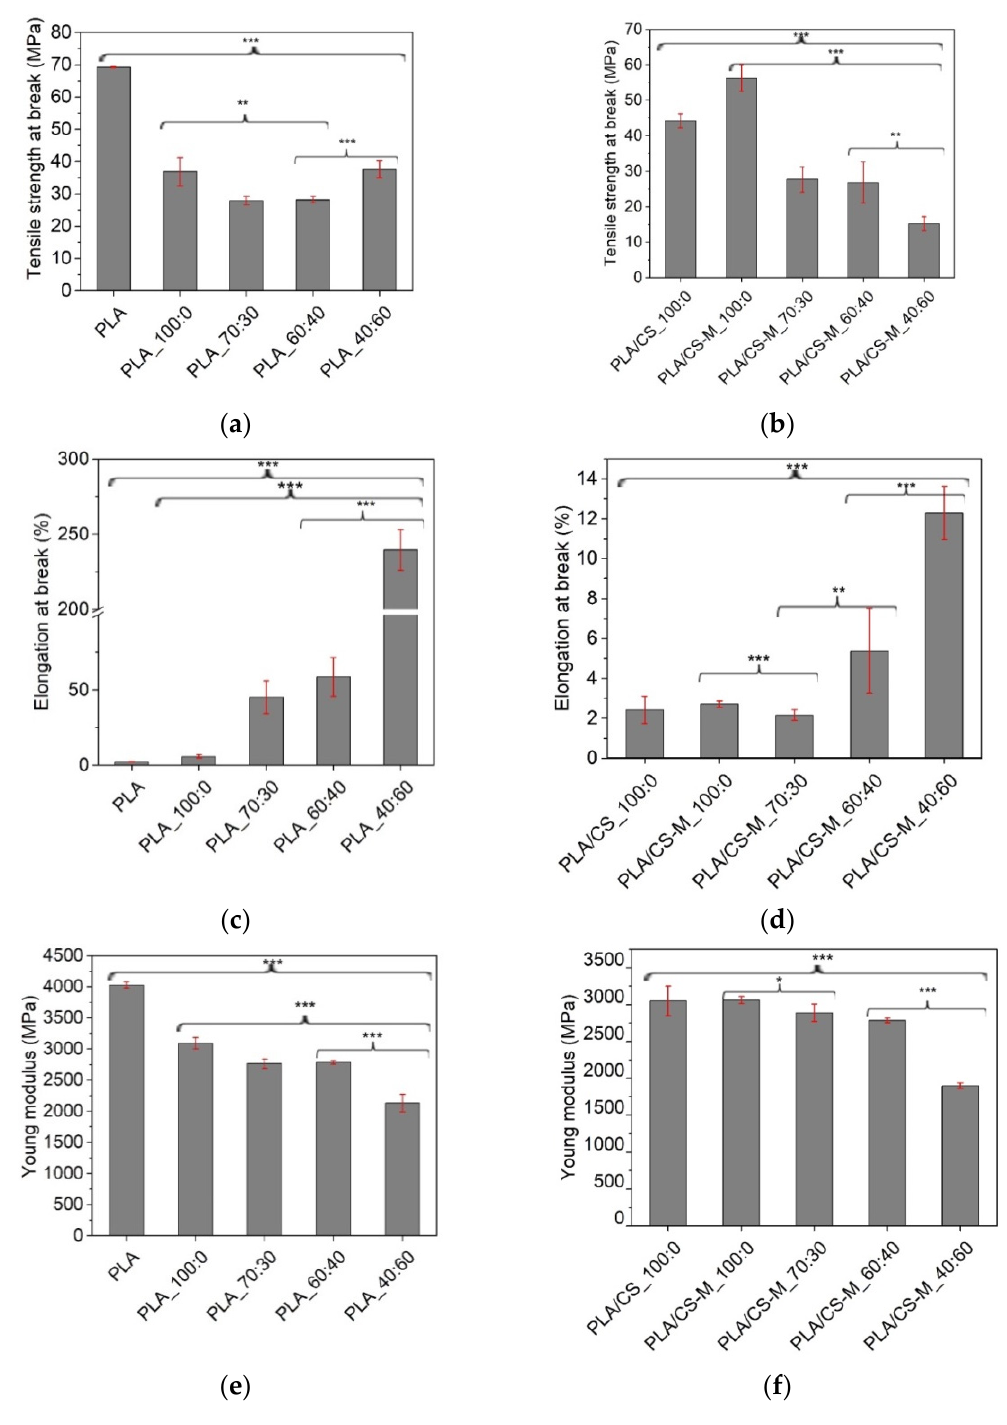
Figure 5. Tensile strength at break for PLA biocomposites containing MB/PEG bio-plasticizers ( a ), and same composites with CS-M ( b ), Elongation at break for PLA biocomposites containing MB/PEG bio-plasticizers ( c ), and same composites with CS-M ( d ), and Young modulus for PLA biocomposites containing MB/PEG bio-plasticizers ( e ), and same composites with CS-M ( f ). The statistical analysis was evaluated with 1-ANOVA test, where: * signifies p < 0.05; ** p < 0.01 and *** p < 0.001. Error bars signify the standard